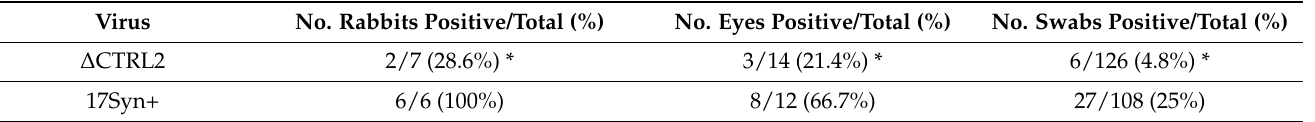
Table 2. In vivo reactivation following the transcorneal iontophoresis of epinephrine & . Virus